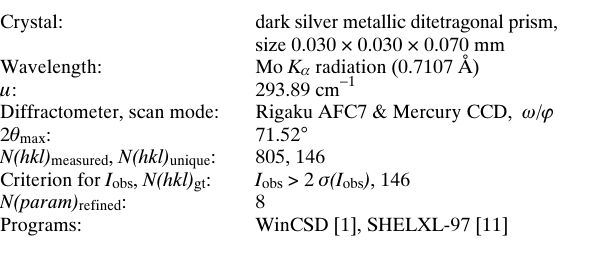
Table 3. Data collection and handling.